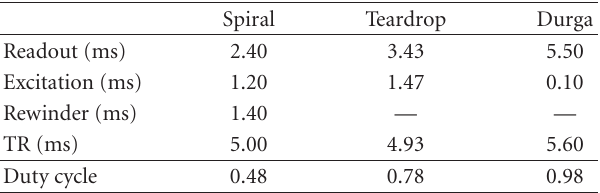
Figure 1: Tubes depicting the 178 selected trajectories. Table 1: Duty-cycle comparison for three balanced k -space sam- pling patterns.